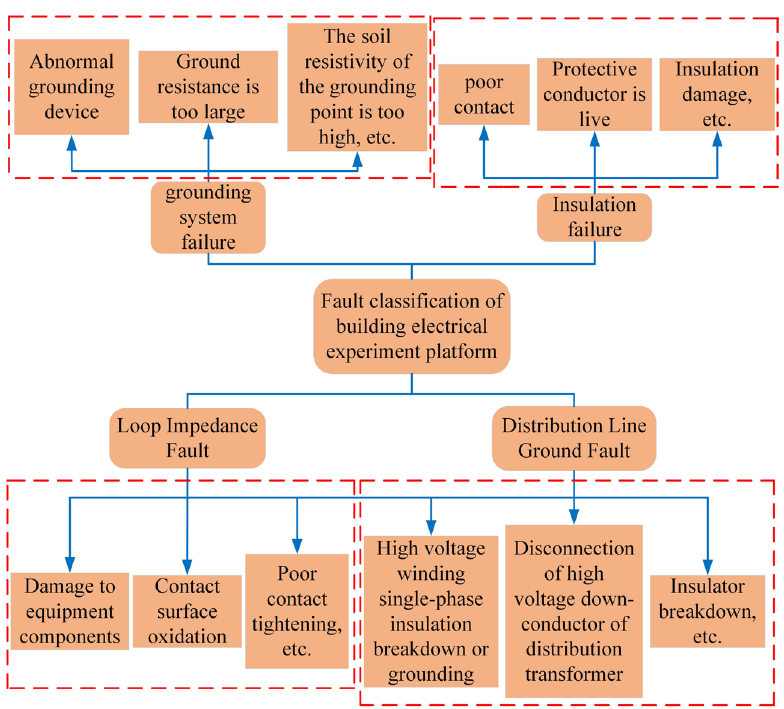
Figure 1. Fault classification diagram of building electrical experiment